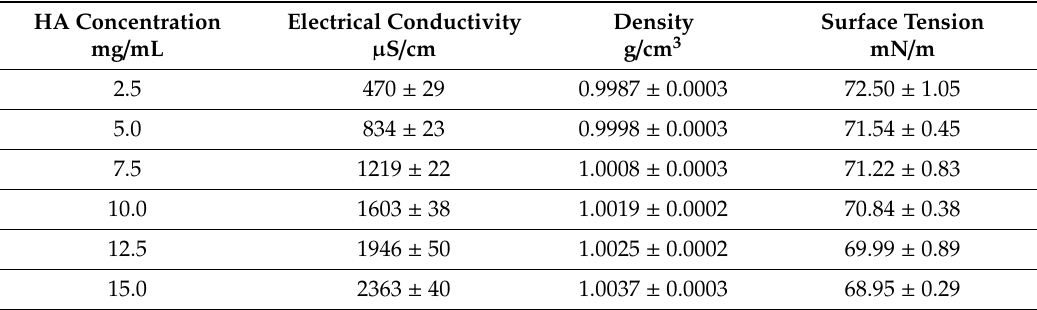
Table 1. Key parameters of the electrospraying polymer